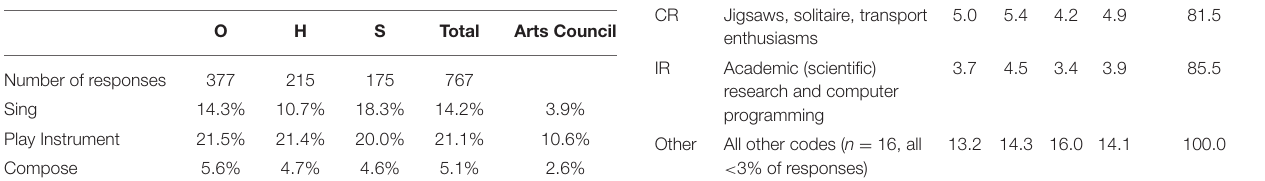
TABLE 9 | Active participation in musical activities at time of survey, by expertise group, in comparison with Arts Council figures for England 2013/14.